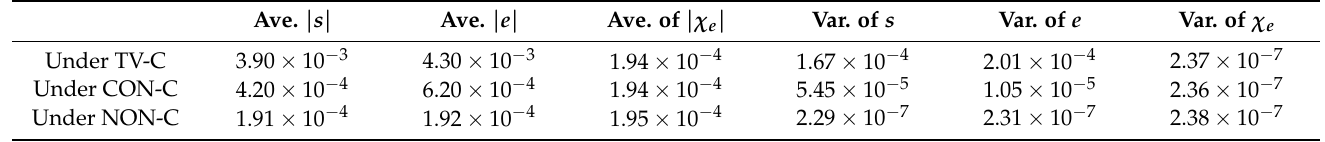
Table 4. The specific data of tracking errors under in Case